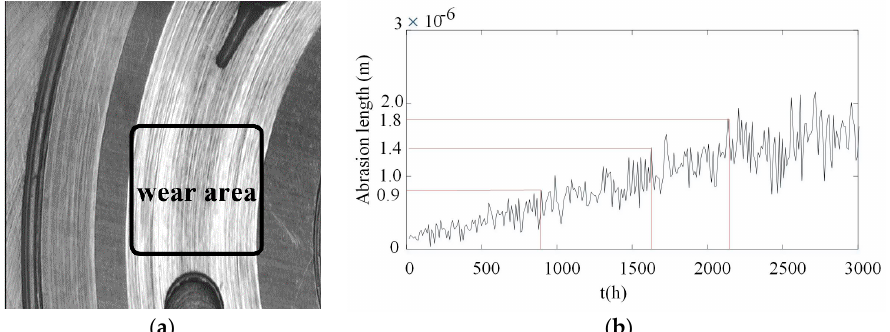
Figure 6. Physical failure process of a valve plate: ( a ) the scratch of valve plate; ( b ) abrasion length.